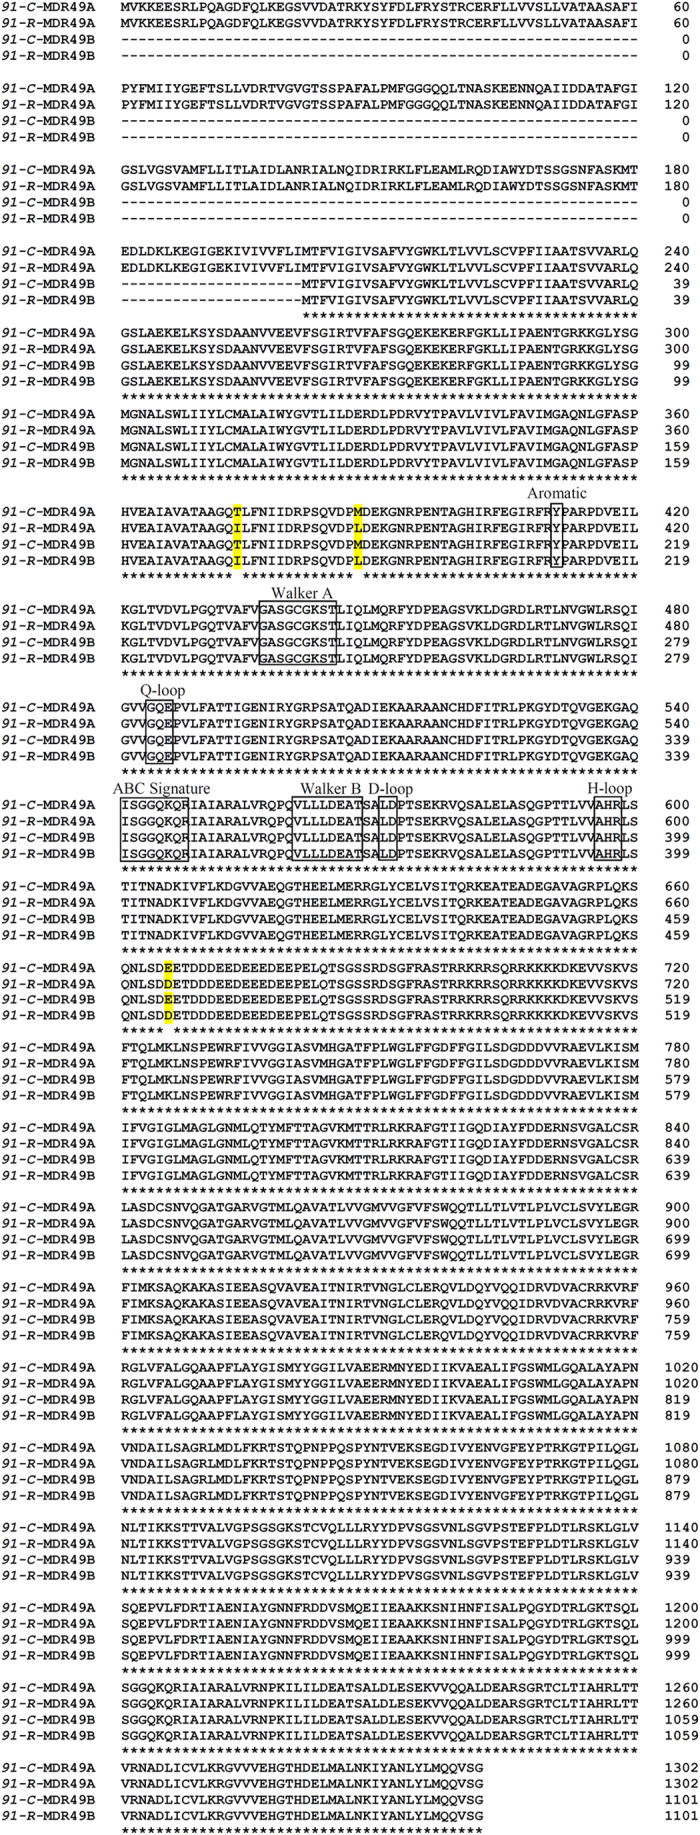
Sequence alignment of putative amino acids deduced from the MDR49 proteins associated with the 91-C and 91-R strains.Three mutations that resulted in amino acid replacements, T374I, M388L, and E666D for MDR49A; T173I, M187L, and E465D for MDR49B were observed in 91-R when compared with 91-C. The NBDs were homologous in both strains and each NBD had seven highly conserved motifs (aromatic, Walker A, Q-loop, ABC signature, Walker B, D-loop, and H-loop), which appear in boxes.